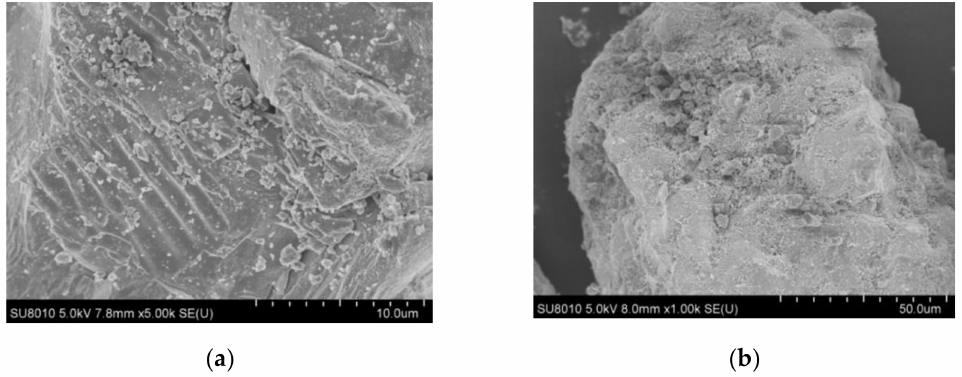
Figure 1. ( a ) SEM images of raw FeS. ( b ) SEM images of the residual FeS. The phase structure of FeS was studied by X-ray diffraction (XRD) analysis. The recorded XRD pattern of the FeS particles is shown in Figure S1a. FeS was dovetailed with tetragonal structure planes with space group P4/nmm (129), corresponding to the standard card of FeS (JCPDS No. 14-0117) [35] assigned to the (101), (110), (111), (200), and (201)